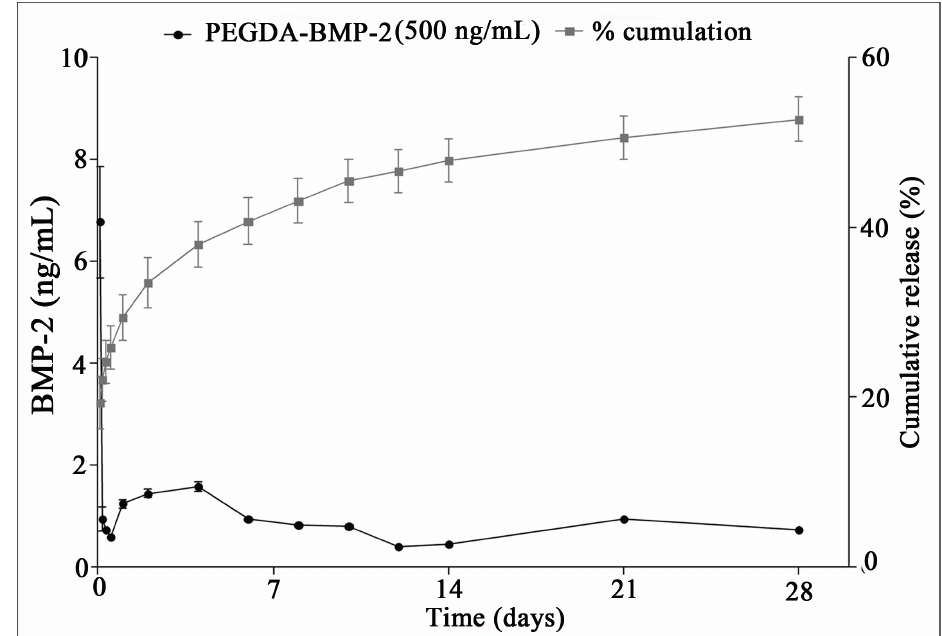
Figure 6. Release profile of bone morphogenetic protein-2 (BMP-2) from 500-ng/mL PEGDA-BMP-2 scaffold on enzyme-linked immunosorbent assay. Black circle graphs showed noncumulative release after each time point. Gray rectangle graphs show the percentage cumulative release. Triplicates were used for each experiment.